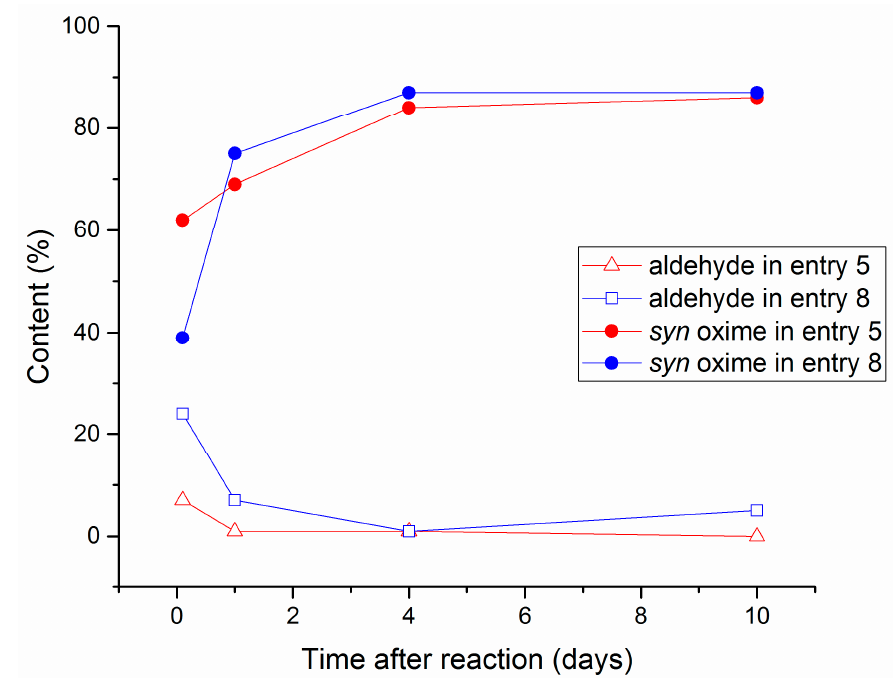
Figure 3. Amounts of non-reacted aldehyde 1 and syn oxime 1a in selected experiments performed in Pulverisette 6 mill in agate chamber determined from 1 H-NMR spectra. Time of milling for entry 5: 30 min, LAG and for entry 8: 5 min. In both entries, 5 eq. NH 2 OH · HCl and 2 eq. NaOH were used. The data reported after 10 days are for the washed samples.